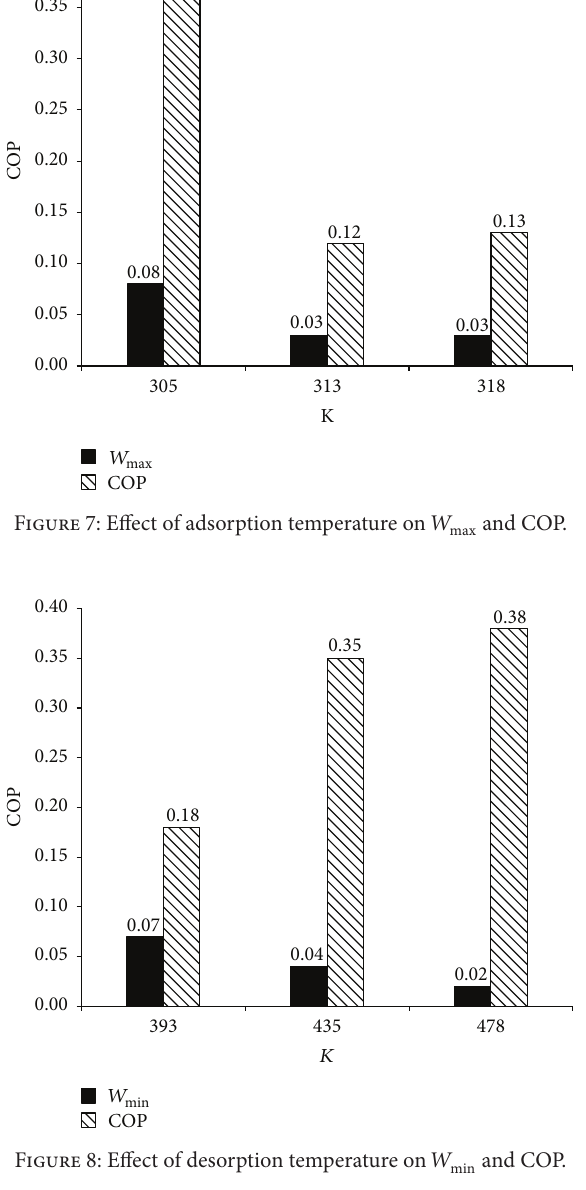
adsorber was transferred to zeolite-4A until it reached the stable stage. After that, vapor was expelled from the zeolite- 4A and shifted to condenser; vapor condensed and collected in the evaporator.